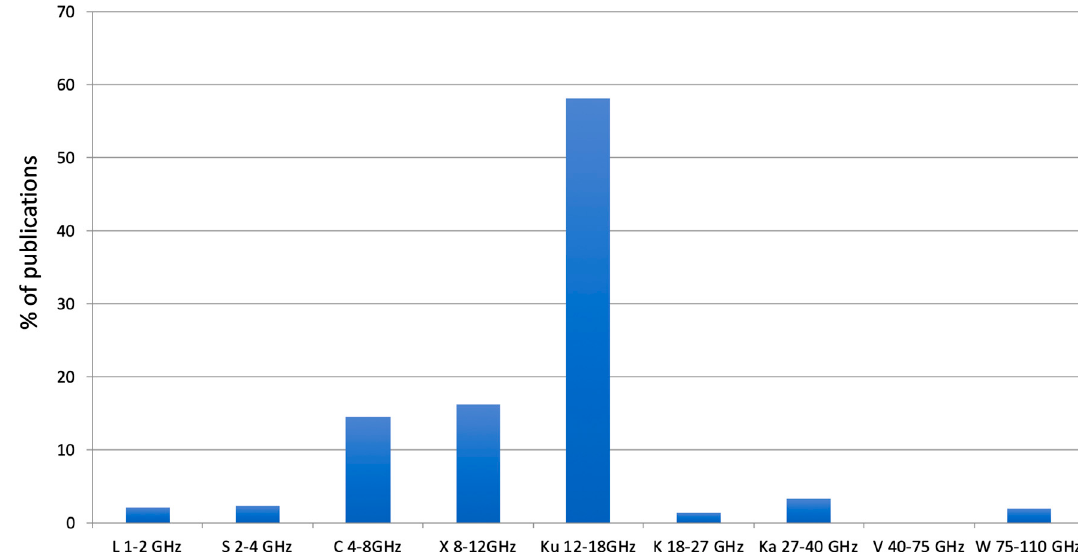
Figure 6. Papers published until December 2018 classified on the basis of the operative band.